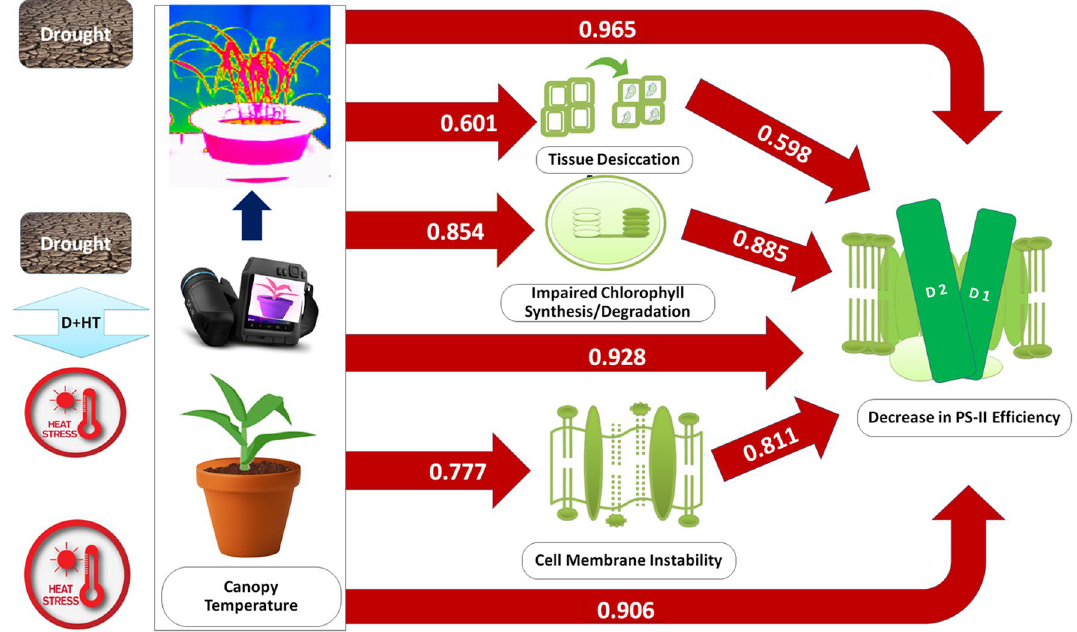
Figure 6. Schematic diagram of the impact of individual and combined effects of drought and heat stress on canopy temperature and other critical physiological parameters in sorghum. Values represent the pearson correlation coefficient between the respective pair of traits (as depicted in Fig. 4). In this figure, the studied parameters viz ., RWC, total chlorophyll, MSI and F v /F m are represented as physiological processes i.e. tissue desiccation, impaired chlorophyll synthesis/degradation, cell membrane instability and decrease in PS-II efficiency,